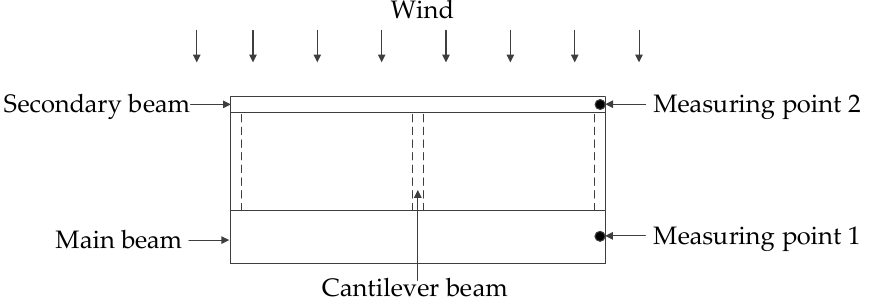
Figure 6. Measuring points of sectional model vibration testing.